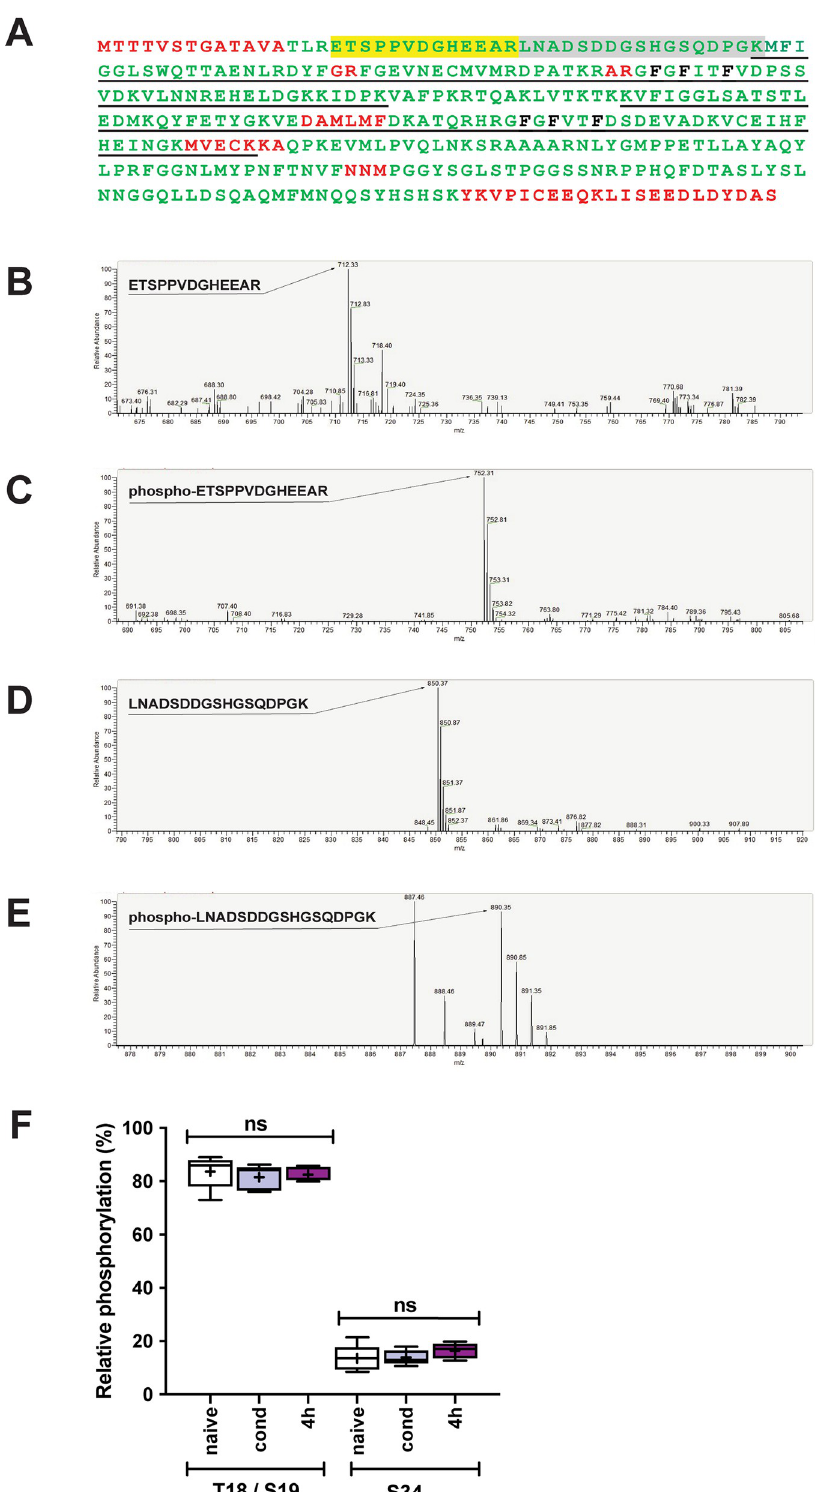
Fig 2. Identification of phosphorylated amino acid residues in C . elegans MSI-1. (A) Amino acid sequence of the full length MSI-1 protein. Residues covered (green), and missing (red) in the mass spectrometry analysis are depicted. Phosphorylated peptides are highlighted: ETSPPVDGHEEAR (yellow) and LNADSDDGSHGSQDPGK (grey).